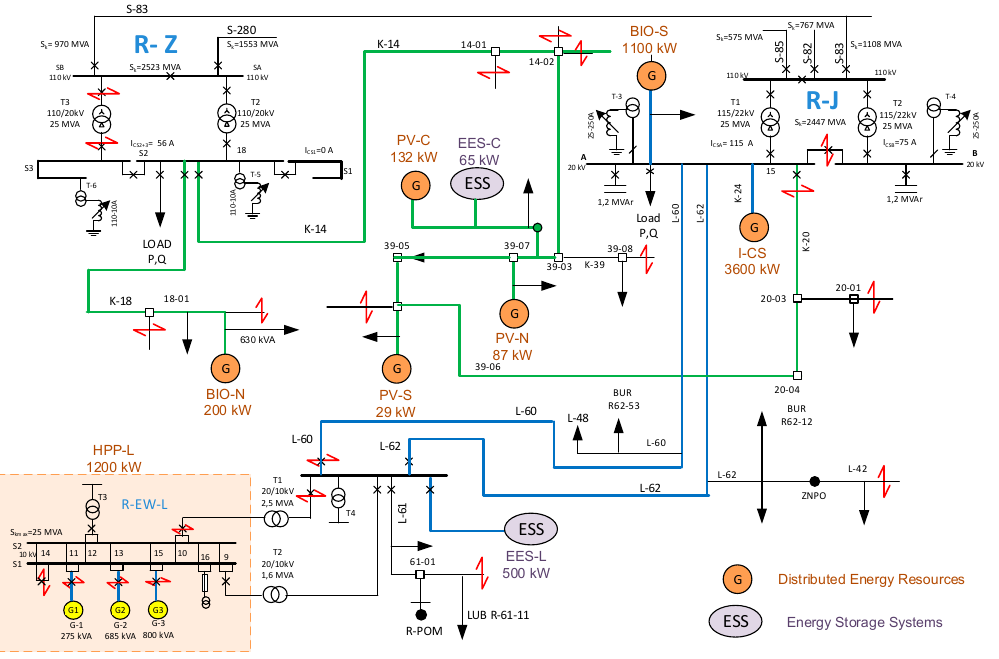
Figure 1. Topology of the planned virtual power plant (VPP).